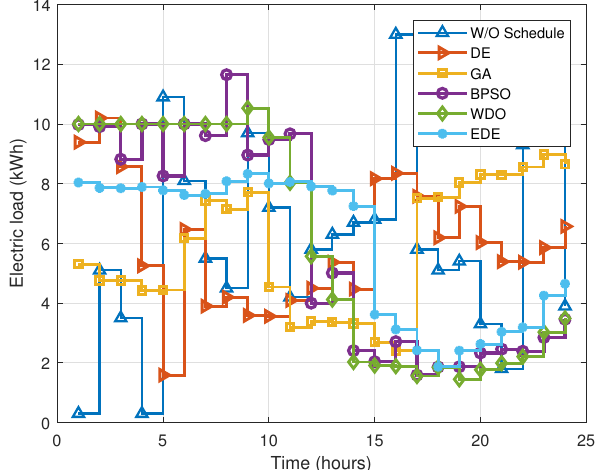
Figure 13. Noninterruptible appliances energy consumption pattern.